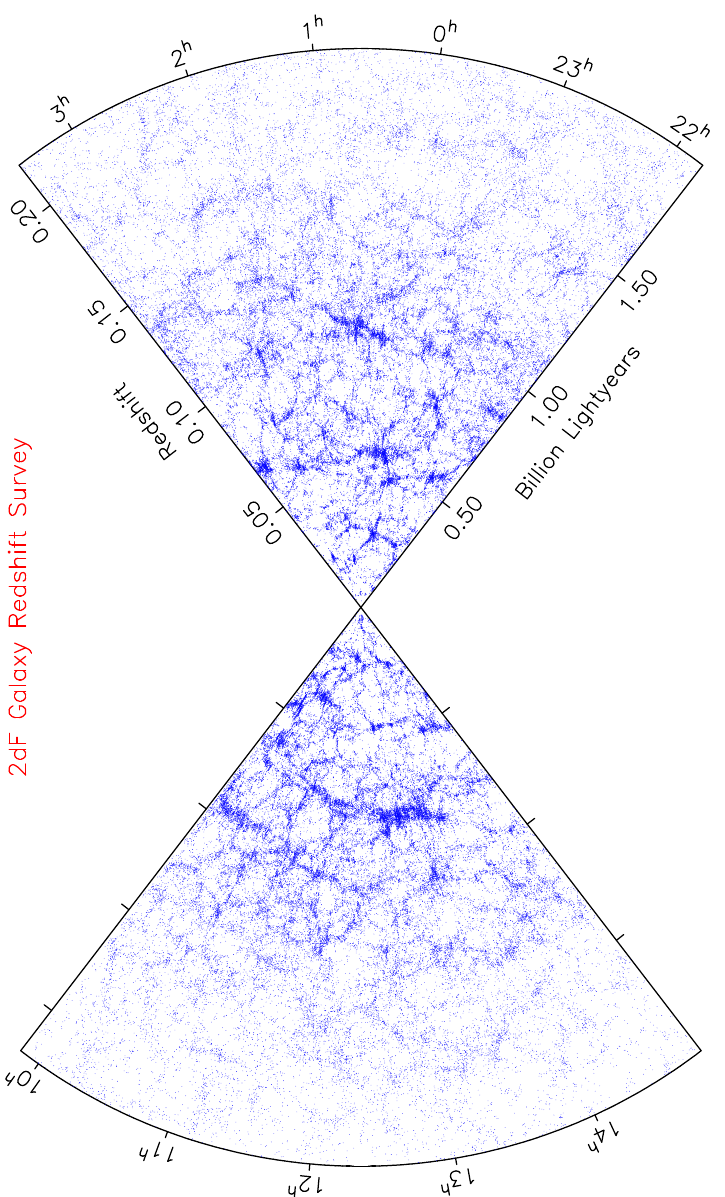
Figure 4. This figure shows the map of the galaxy distribution corresponding to the final data release, the completed survey, of 30 June 2003, of the 2dF Galaxy Redshift Survey (Matthew Colless, Steve Maddox, John Peacock, et al., Anglo-Australian Observatory, http://magnum.anu.edu.au/